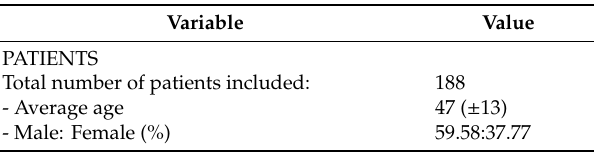
Table 1. Demographic data .